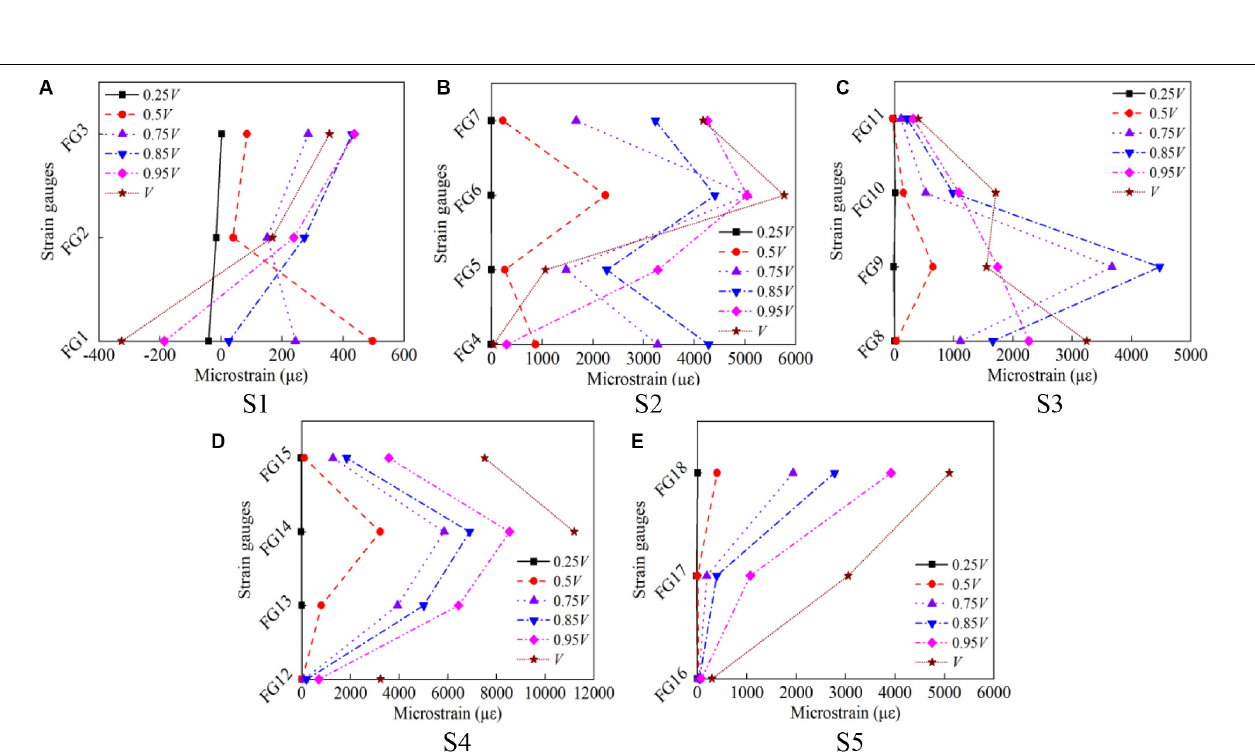
FIGURE 13 | Strain distribution along the height of CFRP strips for HB-1-6. (A) S1, (B) S2, (C) S3, (D) S4, and (E) S5.